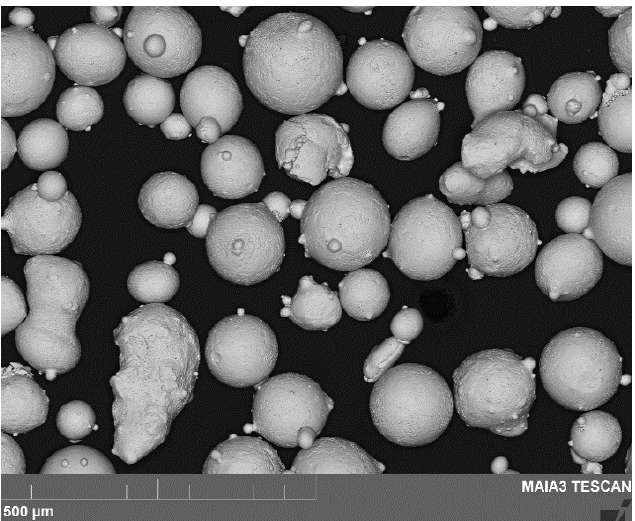
Figure 2. Scanning electron microscope image of 316LN precursor powder, showing mainly spherical powder grains with some satellites attached.